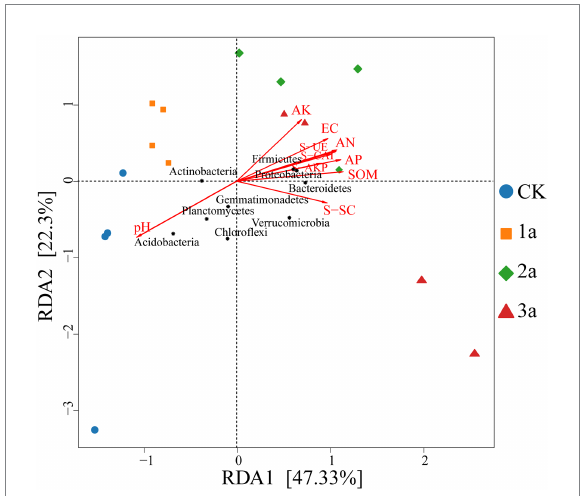
FIGURE 7 Redundancy analysis (RDA) identified the correlation between environmental variables and dominant bacterial plyla. CK, 1a, 2a, and 3a represent greenhouses consecutively planted for 0, 1, 2, and 3 years, respectively. EC, electric conductivity; SOM, soil organic matter; AN, available nitrogen; AP, available phosphorus; AK, available potassium; S-CAT, soil catalase; S-UE, soil urease; S-SC, soil sucrase; and S-AKP, alkaline